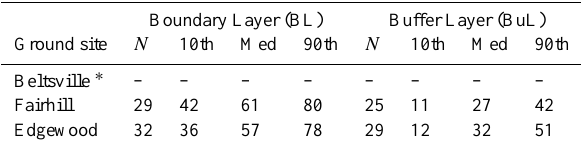
Table 2. The lower 10th, median and 90th percentile of the bound- ary layer and the buffer layer (when it exists) contributions to the total AOD (%). The sample number is given under “ N